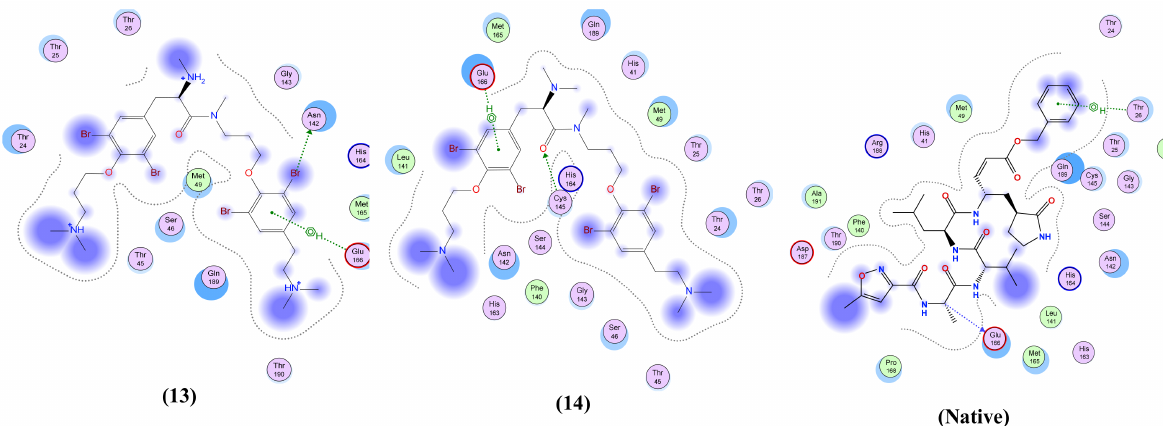
Figure 4. 2D interactions between compounds 1–14 and the native ligand with M Pro (PDB ID: 6lu7). Psammaplysin D ( 5 ) shows the strongest interactions with the spike glycoprotein, having 4 interactions with the active pocket: a H-bond donor between O101 of the ligand and Ser 373 in the pocket; two interactions as a H-bond acceptor; one between O45 of the ligand and Trp 436 of the receptor and another between N77 of the ligand and Val 367 in the pocket; and an H-pi interaction between C48 of the ligand and Trp 436 in the pocket. These interactions are greater than the native ligand, which only has one interaction with the active pocket: a H-bond donor between O6 of the ligand and Ser 343 in the pocket. Fistularin-3 ( 3 ) exhibits 4 interactions: one of them similar to the native ligand but with a better predicted binding affinity, and three more additional H-bond interactions. Two of these interactions are as a H-bond donor, one between O40 of the ligand and Asn 343 of the receptor and the other between O45 of the ligand and Val 367; and 2 H-bonds as an acceptor, one between O12 of the ligand and Gly 339 of the receptor and the other between O29 of the ligand and Ser 373 in the pocket. The 2D interactions for the fourteen library compounds in addition to the native ligand on spike glycoprotein are shown in Figure 5.